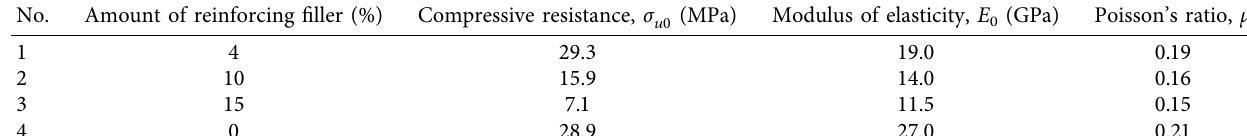
Table 1: Physical and mechanical characteristics of PETF concrete.